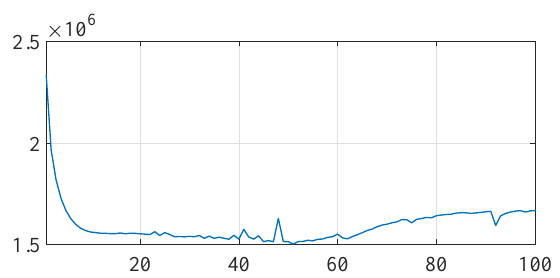
Figure 7. Neural network validation